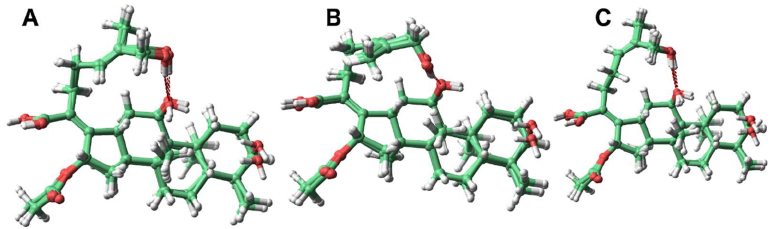
Figure 2. The most abundant conformers of 2 ( A and B ) and 3 ( C ).